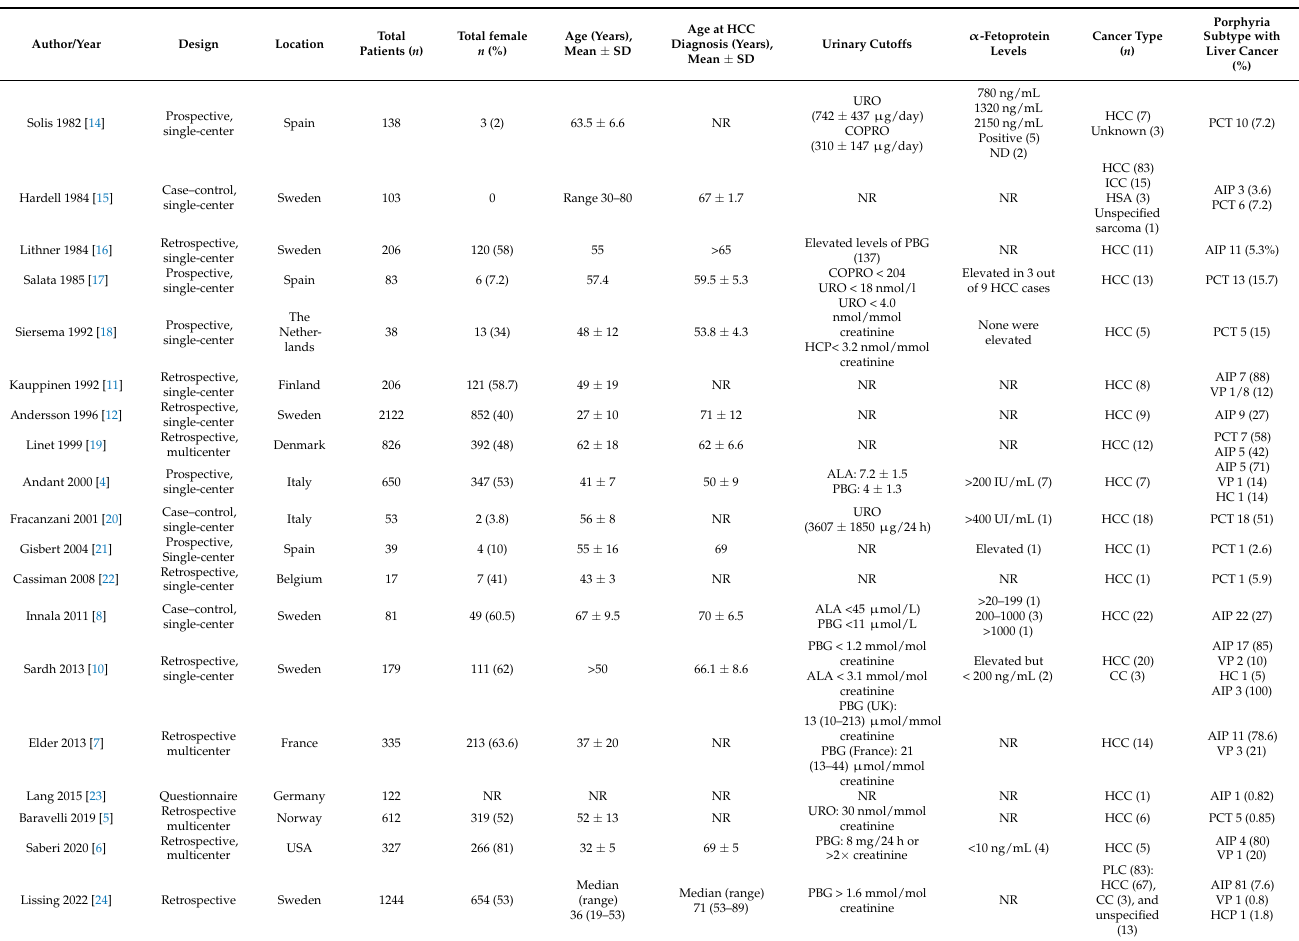
Table 1. Characteristics of the porphyria study population.